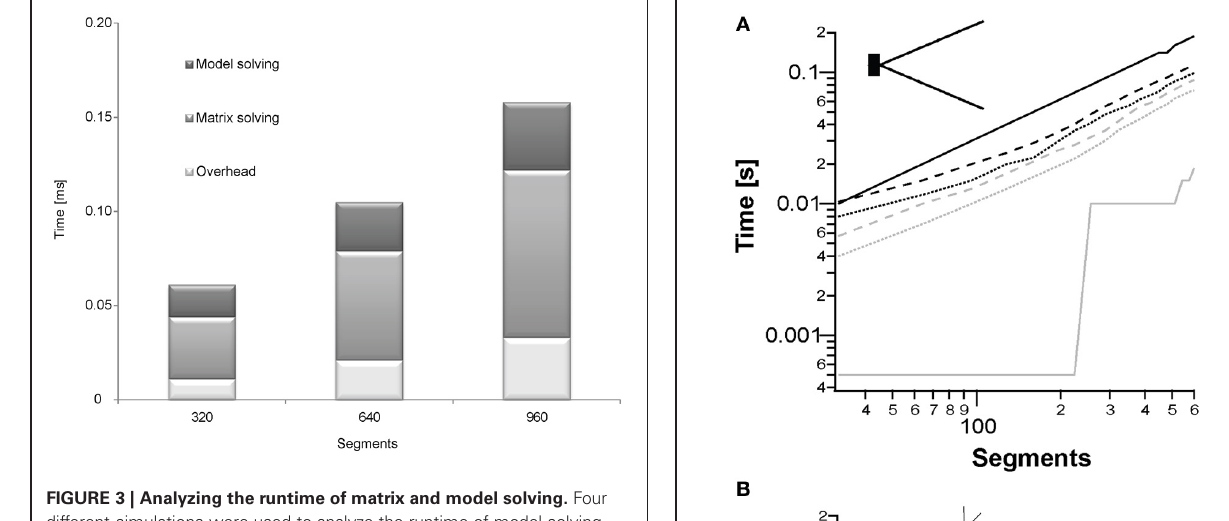
full simulation to calculate the runtime for solving the matrix.